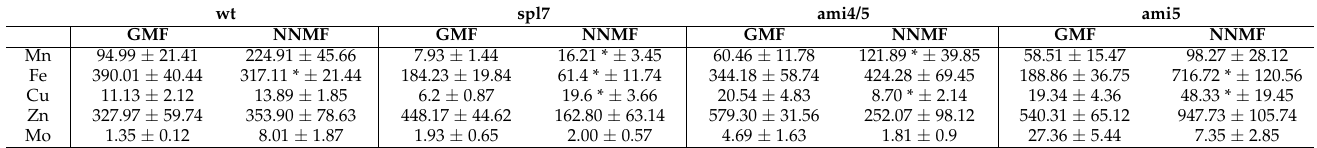
Table 2. Metal contents (Fe, Zn, Cu, Mn, and Mo expressed as µ g/g DW) of Arabidopsis thaliana seedlings (whole plant) grown under full nutrient conditions (C), absence of iron (-Fe), absence of sulfur (-S), and combined Fe and S deficiency (-Fe-S). Determinations were performed 7 days after transferring seedlings to NNMF conditions Data are shown as the means ( ± SE) from four independent biological experiments, whereas the asterisk indicates significant ( t test, p < 0.05) differences between NNMF and GMF plants. wt